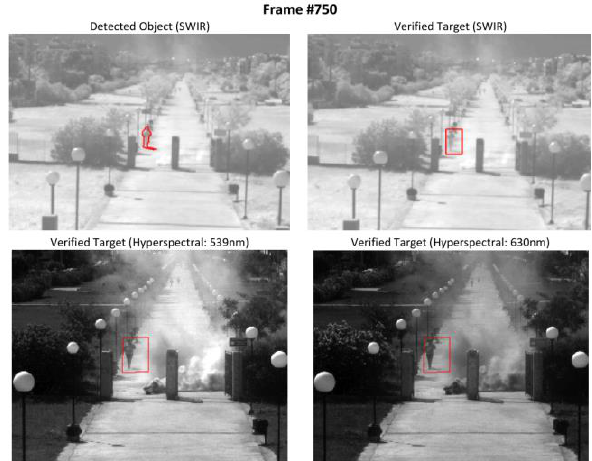
Figure 7: The spectral signature of the possible detected target (top left) from all sensors is stored and analyzed during the fusion and data association module. The same information is also computed regarding the object background which is the rest of the surrounding area inside its bounding